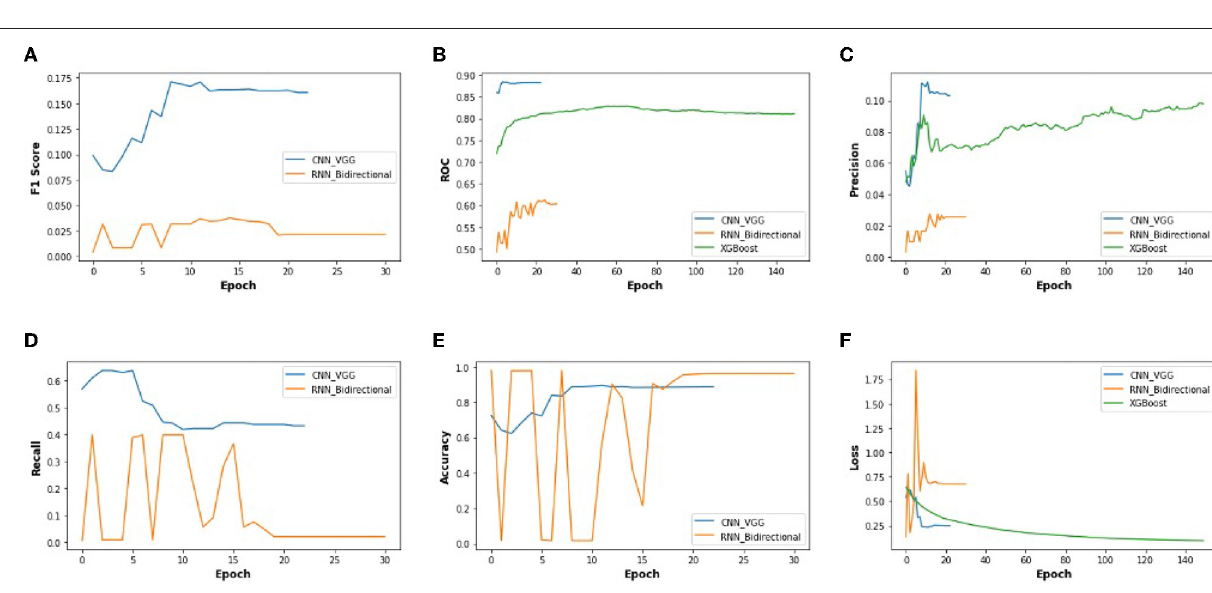
and clouds, ozone, and ground reflection (Cancer-Society, 2021; WHO-Cancer,